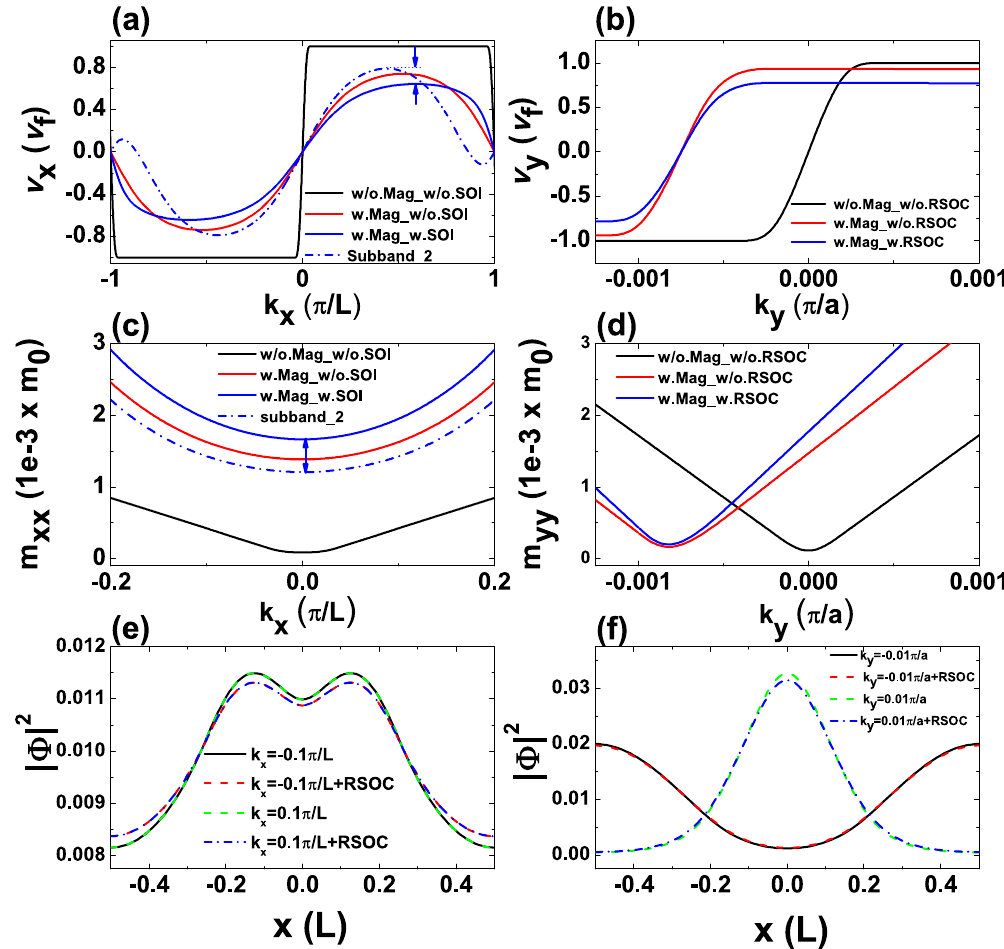
Figure 3. ( a and b ) plot the group velocities v x and v y of electrons in the ground state or the second subband as functions of momentum k x and k y ( B = 1 T , R 0 = 10 2 m / s in case the magnetic field and/or RSOC term are induced). ( c and d ) are the effective masses m xx and m yy as functions of k x and k y . ( e and f ) The probability distribution of carriers in the ground electron states with different k x and k y in a superlattice